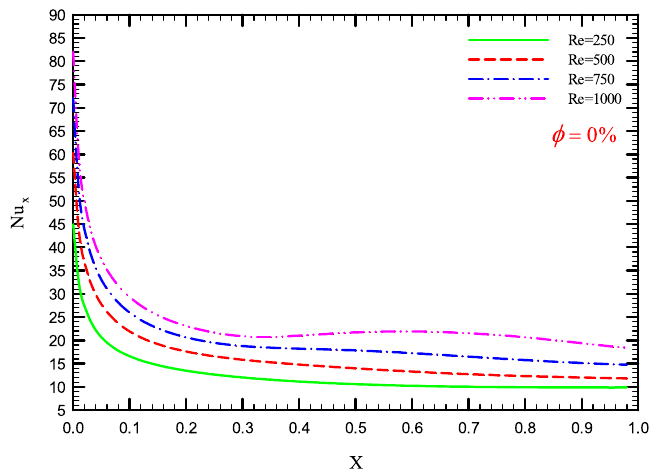
Figure 8. Nu x versus dimensionless length in φ = 0% for Case 4.